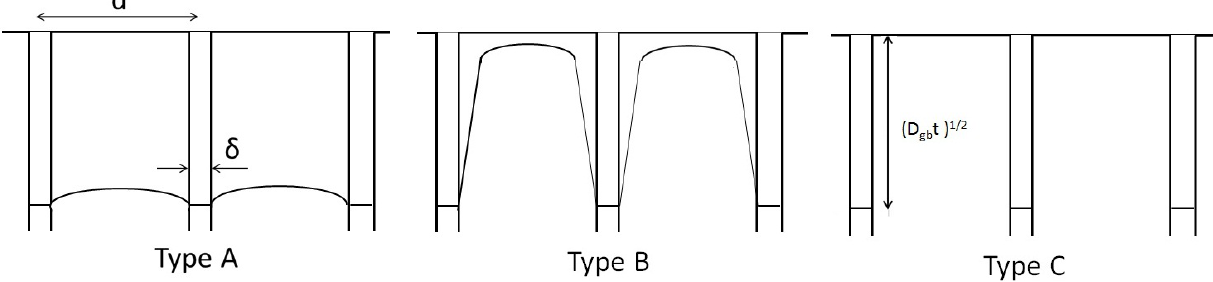
t) 1/2 is grain diffusion gb